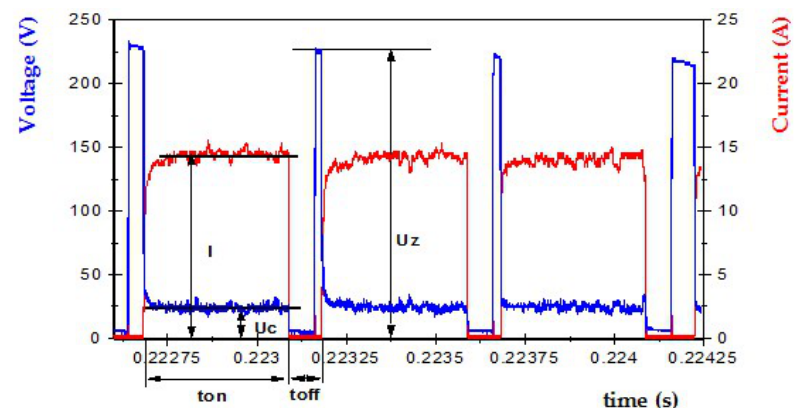
Figure 2. The recorded current and voltage waveforms.